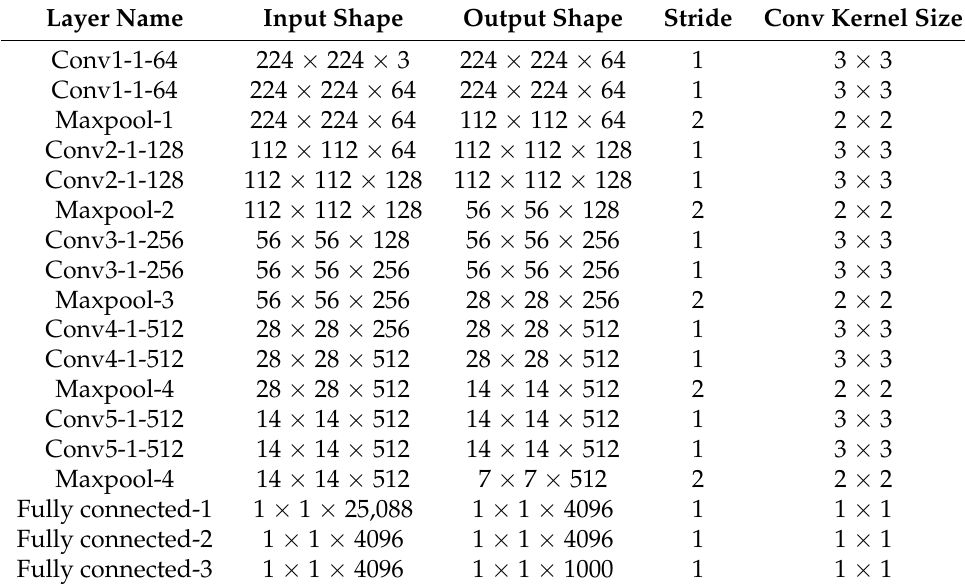
Table 3. The plain VGG16 model parameters in detail [51].